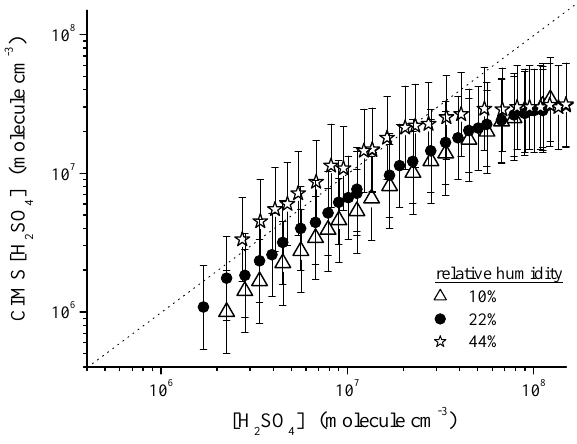
Fig. 1. H 2 SO 4 profiles in the irradiated middle section and the end section of IfT -LFT for SO 2 concentrations of 6.3 × 10 9 and 5.3 × 10 10 moleculecm − 3 (total flow: 11lmin − 1 STP; O 3 : 3.5 × 10 11 moleculecm − 3 ; CO: 2.1 × 10 14 moleculecm − 3 ). The dashed lines represent the average H 2 SO 4 concentrations in the ir- radiated middle section of 3.4 × 10 6 and 2.8 × 10 7 moleculecm − 3 . The dashed lines show the average H 2 SO 4 concentra- tions in the irradiated middle section, i.e., 3.4 × 10 6 and 2.8 × 10 7 molecule cm − 3 for the considered SO 2 concen- trations of 6.3 × 10 9 and 5.3 × 10 10 molecule cm − 3 , respec- tively. Corresponding maximum H 2 SO 4 concentrations at the end of the irradiated middle section are 5.3 × 10 6 and 4.4 × 10 7 molecule cm − 3 .